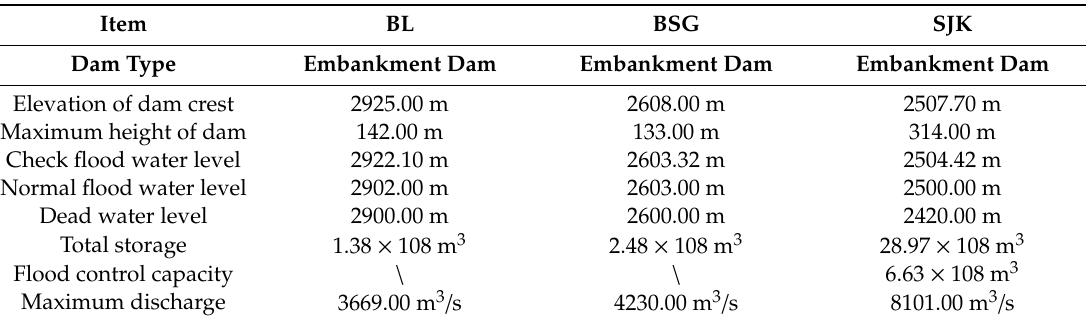
Table 1. Main parameters of cascade